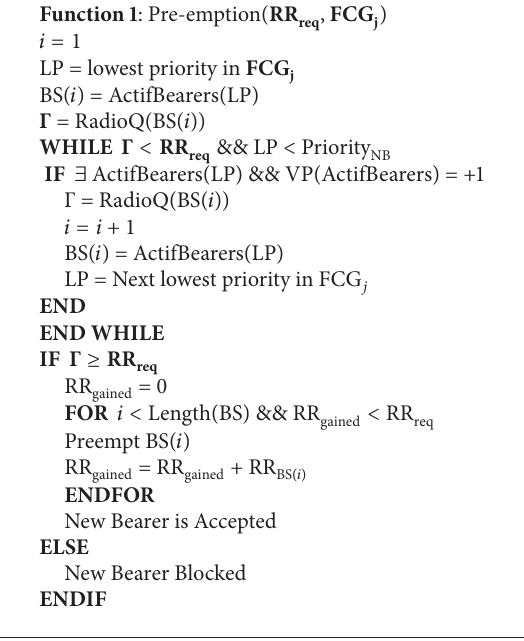
Algorithm 3: Preemption